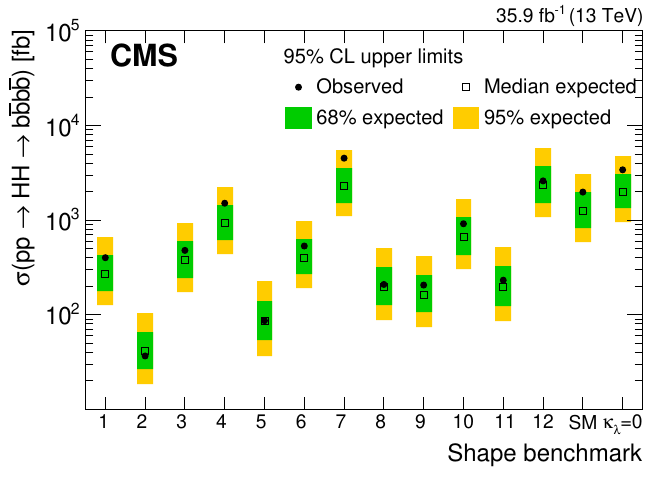
Figure 6 . The observed and expected upper limits for non-resonant HH production in the standard model, the model with (cid:20) (cid:21) = 0, and other shape benchmarks (1{12), combining the fully-merged selection and the semi-resolved selection (where the events used in the fully-merged analysis are not considered in the semi-resolved analysis). The inner (green) and the outer (yellow) bands indicate the regions containing the 68 and 95%, respectively, of the distribution of limits expected under the background-only